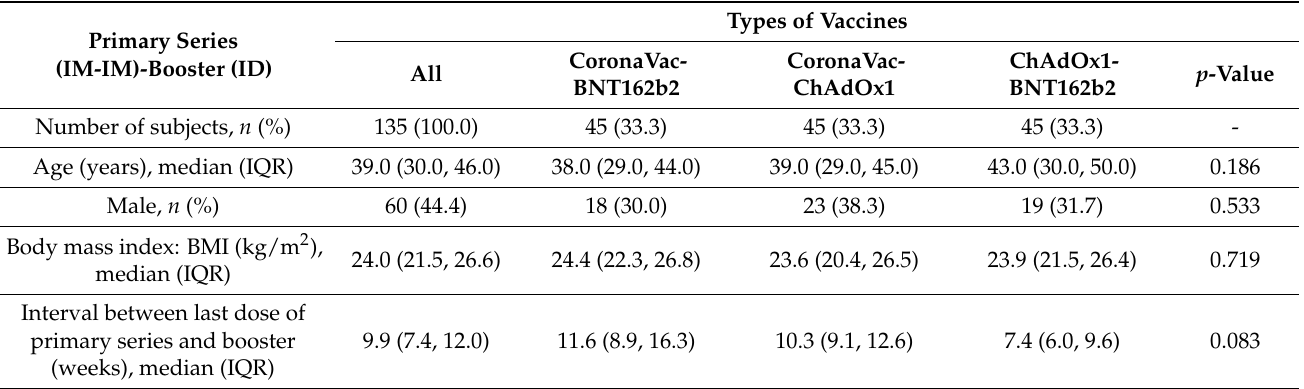
Table 1. Baseline characteristics of the participants of each group in the initial and extended